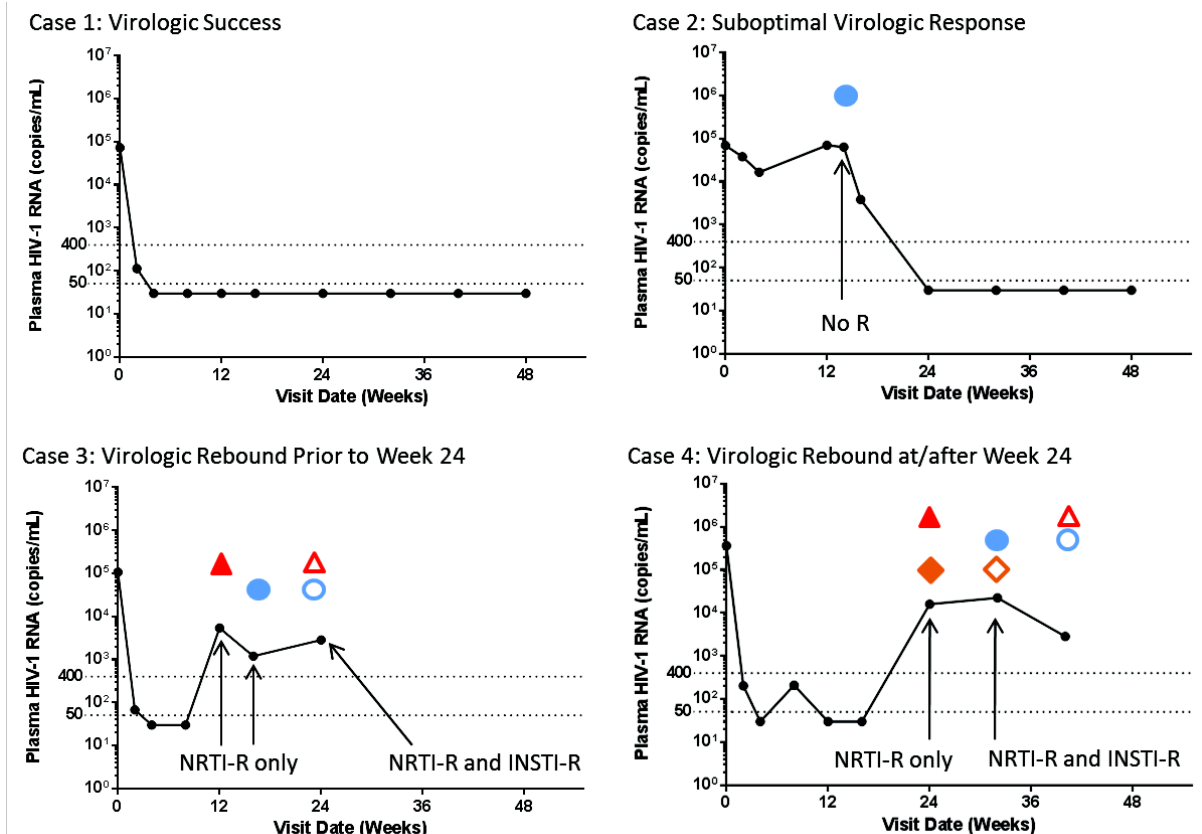
Figure 1. Resistance analyses and HIV-1 RNA profiles of eight clinical case studies by study visit. Plasma HIV-1 RNA in copies/mL are indicated on the y-axis, with values at 50 copies/mL and 400 copies/mL indicated by the dotted horizontal lines. The time in weeks of the scheduled and unscheduled study visits are indicated on the x-axis. The viral load at each visit is plotted (black circles and black lines). Emergent resistance to the NRTI or INSTI class is indicated at specific visits with an arrow and text. The RAL Protocols use red triangles ( ▲ ), the EVG Protocols blue circles (●) and the DTG Protocols orange diamonds ( ♦ ). Filled symbols represent the point at which resistance testing would be conducted. Open symbols represent the visit where a patient would be discontinued from study drugs. No R indicates no nucleos(t)ide reverse transcriptase inhibitor (NRTI) or INSTI resistance